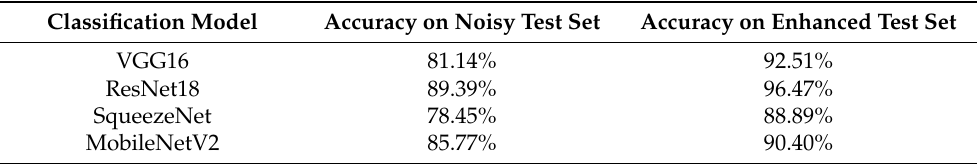
Figure 4. Frequency spectrums of 4 noisy boring vibration segments (column a ) and the frequency spectrums of the same segments after enhancement using VibDenoiser (column b ). Table 5. Classification results of four well-known classification models on the test set and VibDenoiser enhanced test set,